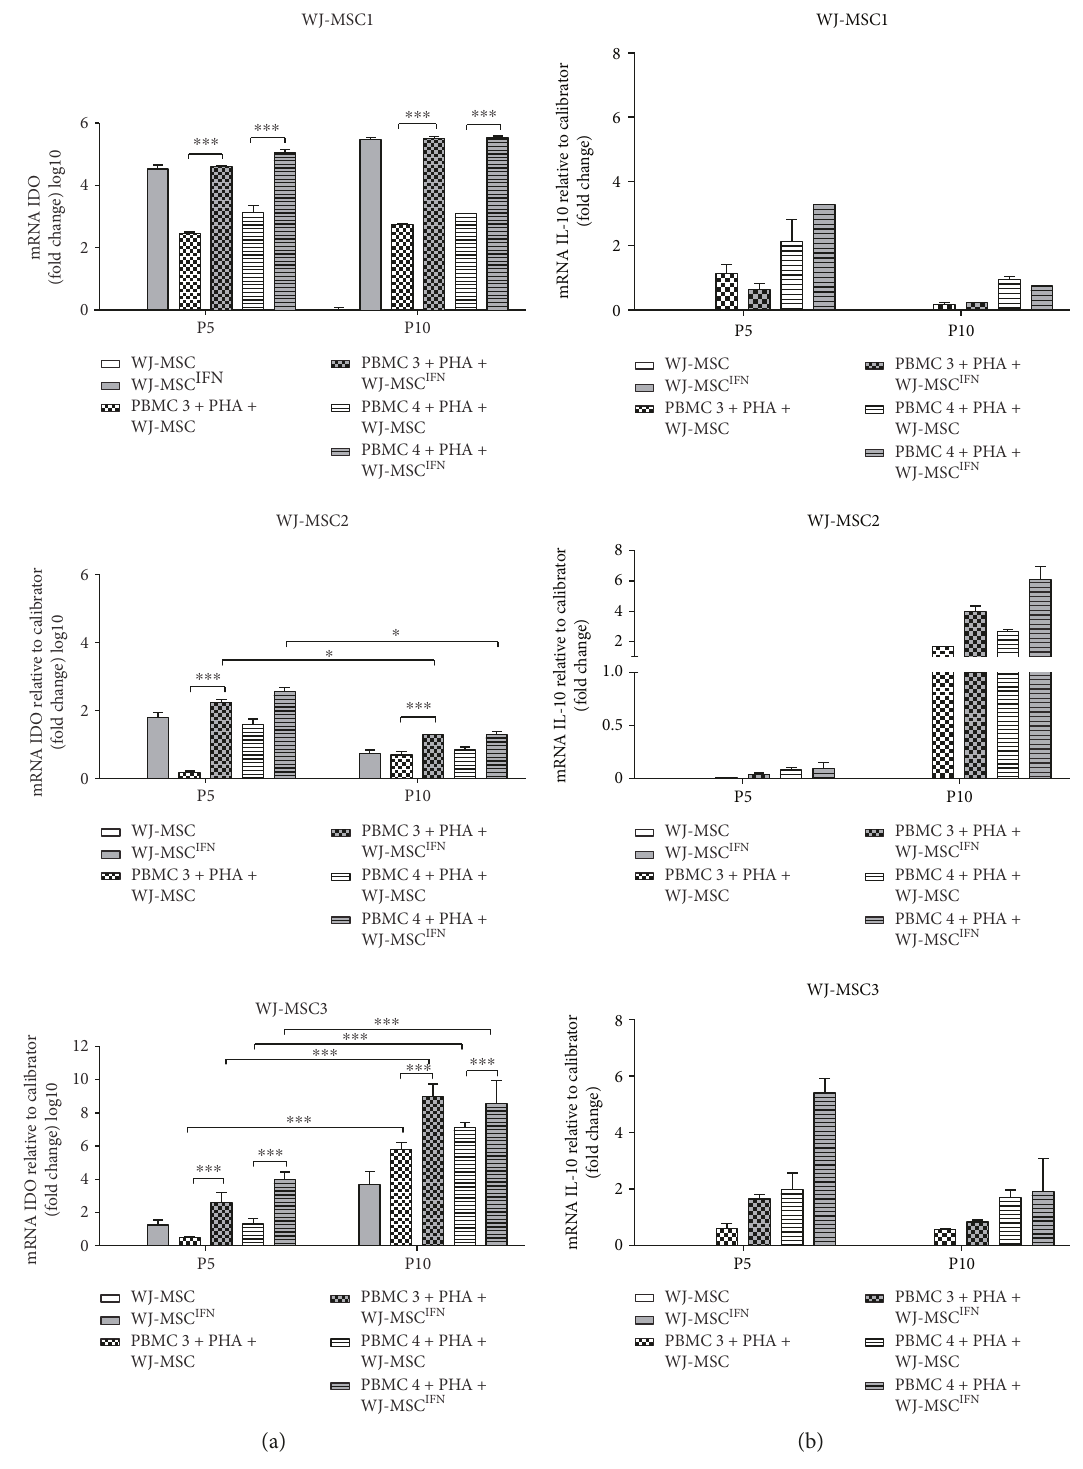
Figure 5: Gene expression of IL-10 and IDO is increased in WJ-MSC after coculture with PBMC. WJ-MSC were seeded, after 24 hours. PBMC was added and stimulated with PHA for 3 days in the presence of MSC; the ratio used was 1: 10 (MSC : PBMC). The WJ-MSC passages used in the experiments were P5 and P10. After 3 days, WJ-MSC were lysed, total RNA extracted, and real-time PCR performed. (a) IDO and (b) IL-10 gene expression of WJ-MSC1, WJ-MSC2, and WJ-MSC3. Gene expression was normalized by GAPDH and expressed as fold change compared to the control WJ-MSC. Experiments were performed in triplicate. Results are represented as mean ± SD. Statistically signi fi cant di ff erences are shown as ∗ p < 0 05 , ∗∗∗ p < 0 0001 ( n = 3